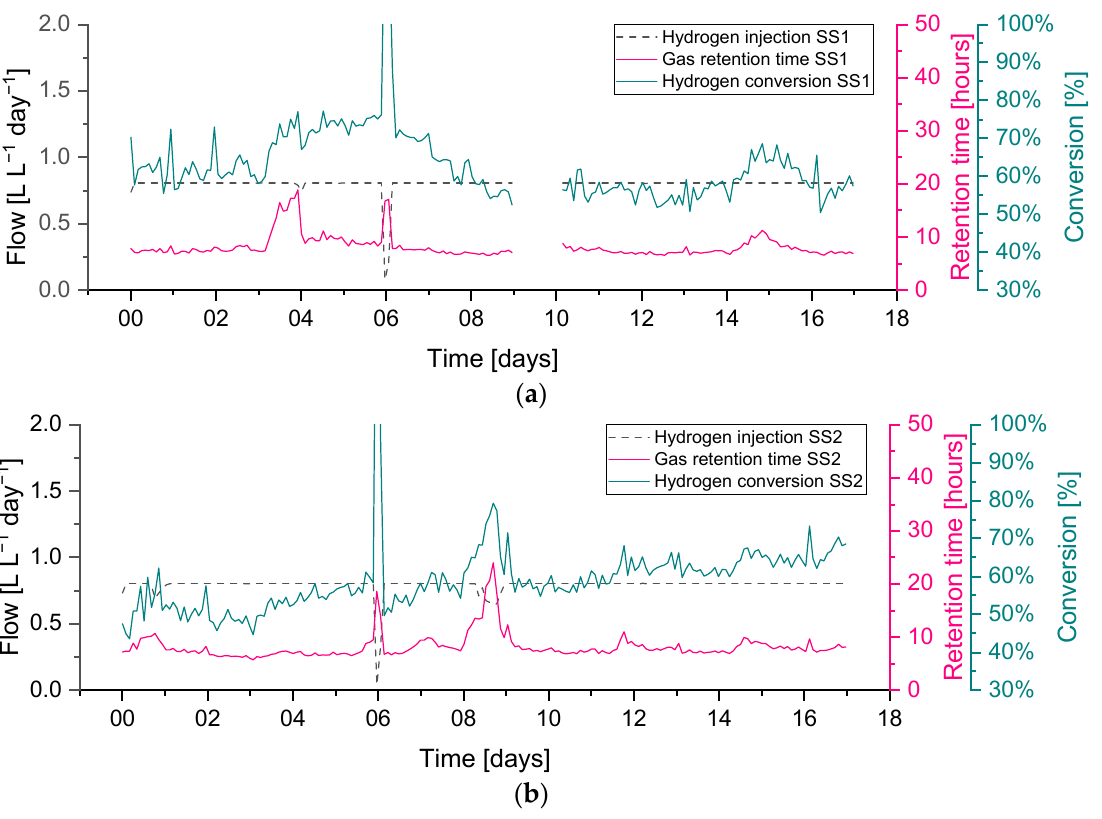
Figure 9. Hydrogen conversion in relation to gas retention time and hydrogen injection rate during period R1 for sewage sludge (SS)-fed reactors: ( a ) biomethanation reactor SS1, ( b ) biomethanation reactor SS2 .